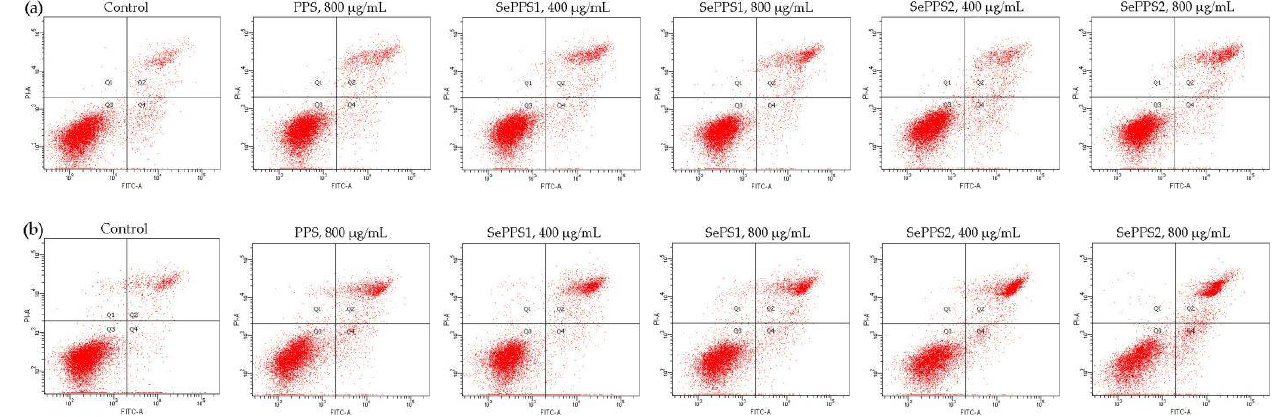
Figure 6. The apoptosis induction of P. oleracea polysaccharides (PPS) and two selenylated PPS products (SePPS1 and SePPS2) at two dose levels in HCT-116 cells with treatment times of 24 ( a ) and 48 h ( b ). Table 3. The measured total apoptotic percentages (Q2 + Q4) of HCT-116 cells exposed to P. oleracea polysaccharides (PPS) and two selenylated PPS products (SePPS1 and SePPS2) for 24 and 48 h.